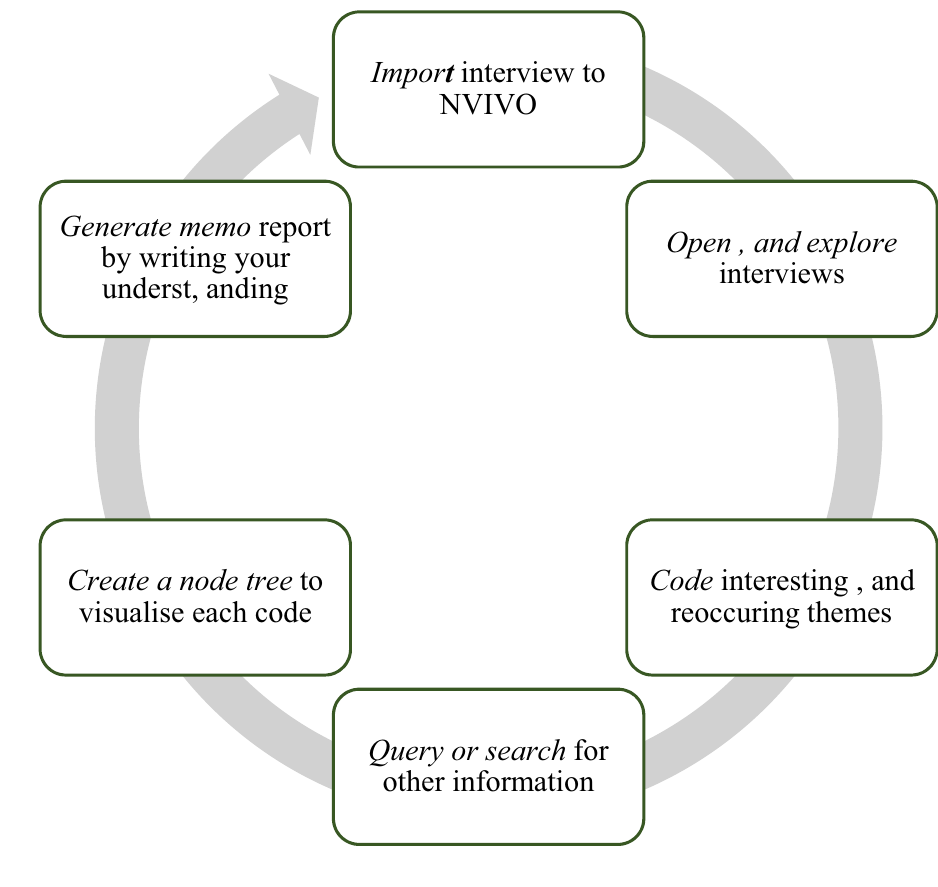
Fig. 2 Process of identifying themes from interview tran- scripts. Source: Developed by the authors